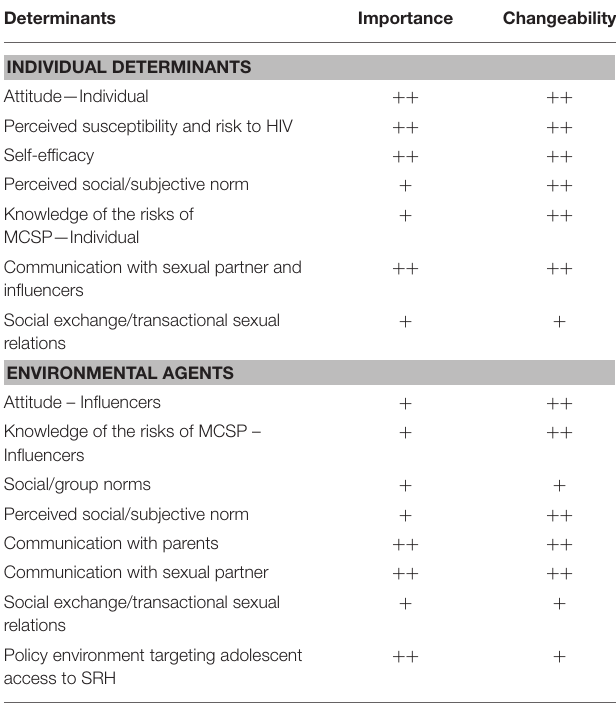
TABLE 4 | List of determinants providing possible answers for reducing adolescent